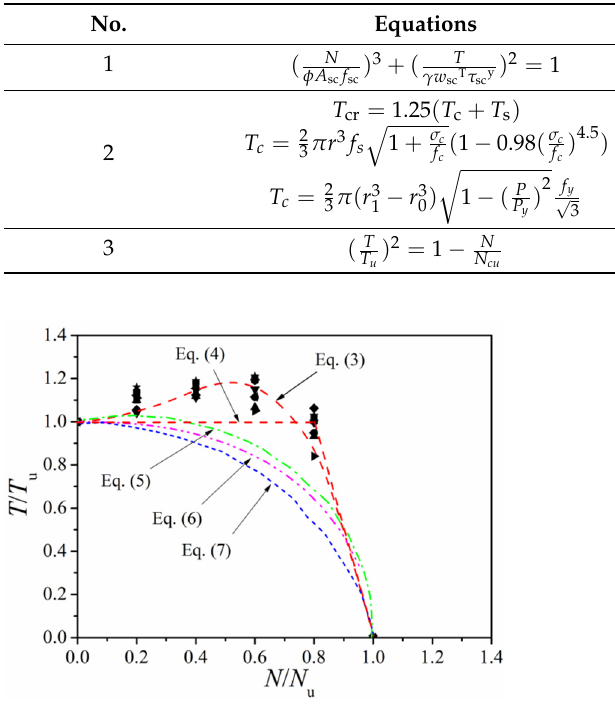
Figure 16. Comparison of design equations. Table 3. Comparison of different calculation formulas.